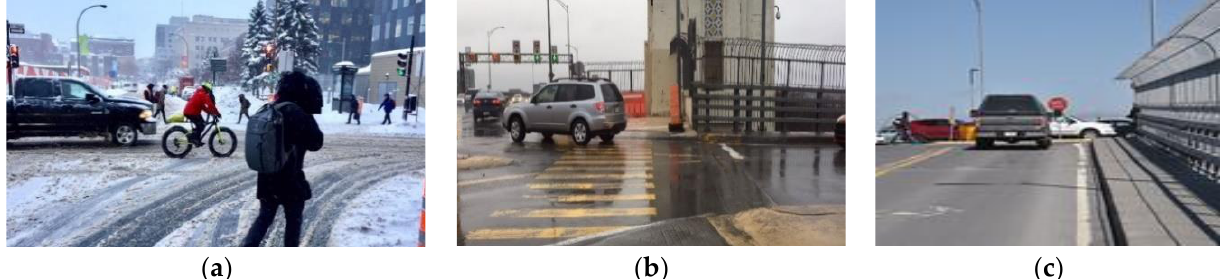
Figure 1. Representation of different types of road surface condition [38]. ( a ) Snowy road; ( b ) wet road; ( c ) dry road.